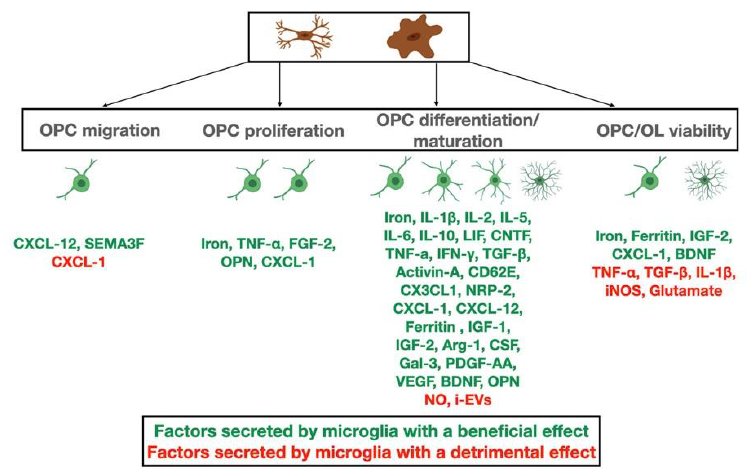
Figure 2. Inflammatory factors secreted by microglia during demyelination and remyelination that affect OPC migration, proliferation and differentiation to mature myelinating OLs, as well as OPC/OL survival. Factors with beneficial effects are listed with green color, while factors with detrimental effects are listed with red color.